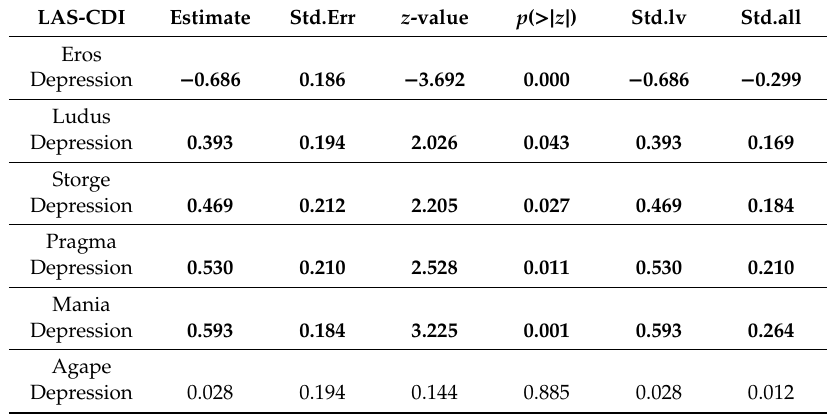
Table 1. Regression analyses of the LAS (Love Attitudes Scale) on the CDI (Children’s Depression Inventory) as predictors in males.